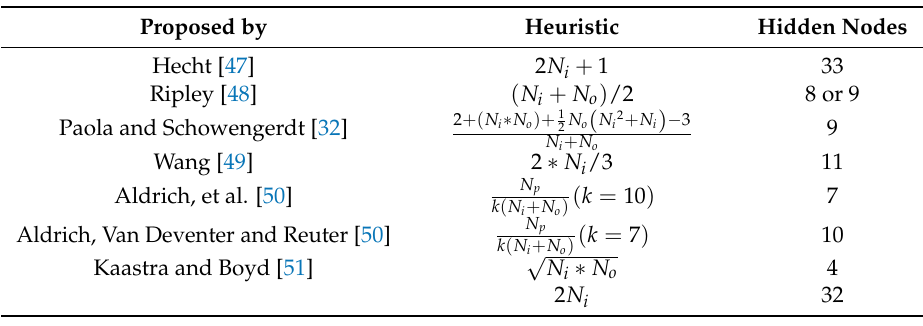
Table 5. The heuristics proposed to compute the optimum number of hidden layer nodes for NNET (modified from and Kavzoˆglu [46]; N i : number of input nodes (i.e., the total number of variables of 16 in this study); N o : number of output nodes ; N p : Number of training samples; k : the noise factor (varies between 4 and 10) is an index number representing the percentage of false measurements in the data or degree of